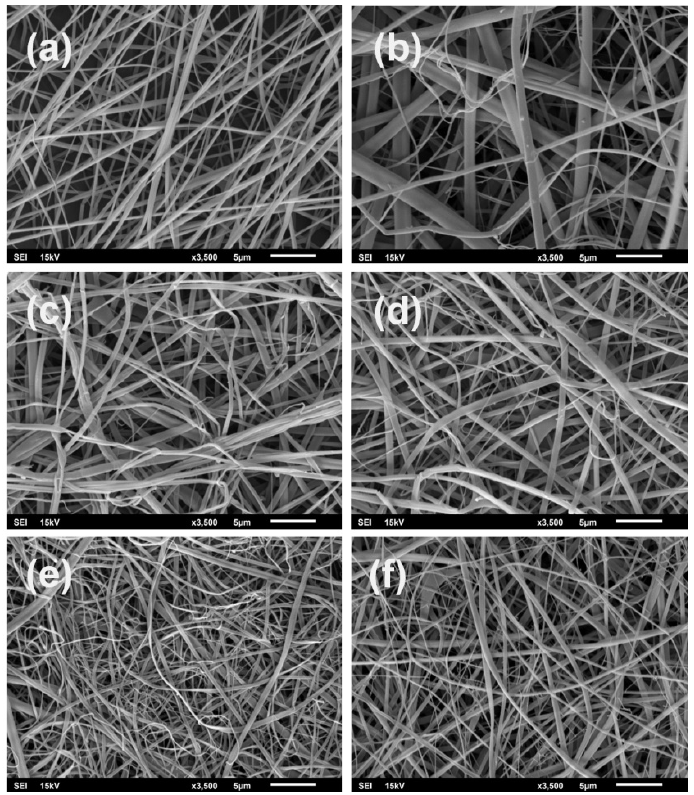
Figure 1. SEM images of electrospun silk fibroin composites: ( a ): SFs, ( b ): CSFs, ( c ): SFs/15%DSS, ( d ): SFs/30% DSS, ( e ): CSFs/15%DSS, ( f ): CSFs/30%DSS. Table 2. The average diameter of individual electrospun fibrous mats A–F (see Figure 1) and their contact angles. All values are expressed as a mean ±